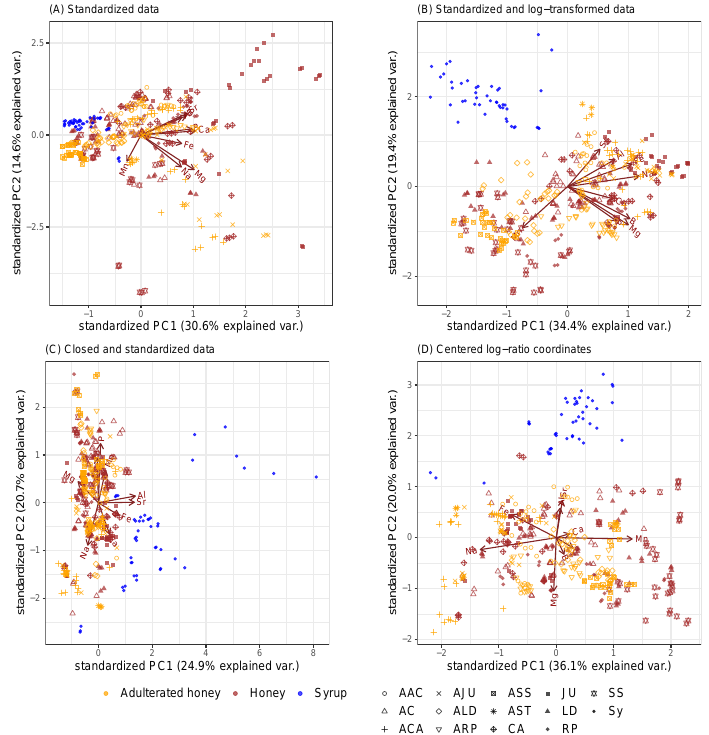
Figure 1. Biplots obtained from honey samples (pure and adulterated). First, two principal compo- nents represented by biplots of the PCA applied on ( A ) standardized data, ( B ) standardized and log-transformated data, ( C ) closed and standardized data, and ( D ) centred log-ratio coordinates. Abbreviations of various type of honey: AC: Acacia , CA: Chaste , JU: Jujube , LD: Linden , SS: T. cochinchi- nensis , RP: Rape ; and various types of sugar syrups: Sy; and adulterated honey categories: AAC (adulterated Acacia ), ACA (adulterated Chaste ), AJU (adulterated Jujube ), ALD (adulterated Linden ), ARP (adulterated Rape ), ASS (adulterated T. cochinchinensis